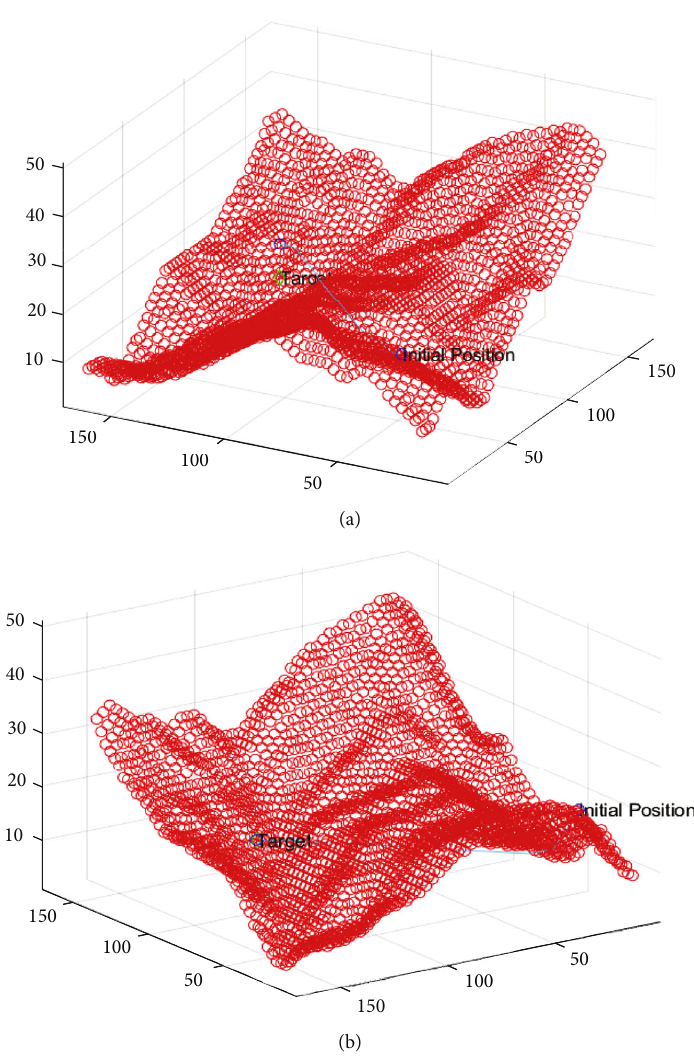
Figure 9: Path planning for simulating group 2 with the optimal A ∗ algorithm (a) and traditional A ∗ algorithm